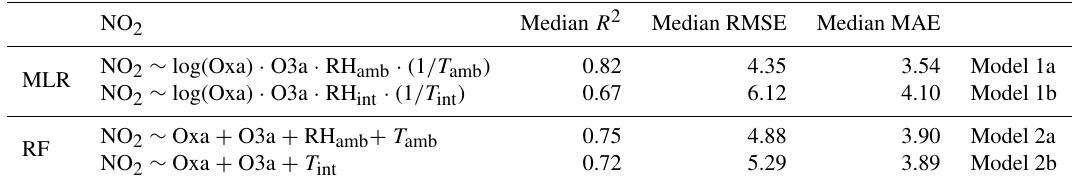
Table 6. Median R 2 and RMSE across all test blocks of the best MLR and RF models using internal and ambient T and RH for NO 2 . RMSE and MAE are reported in units of parts per billion.